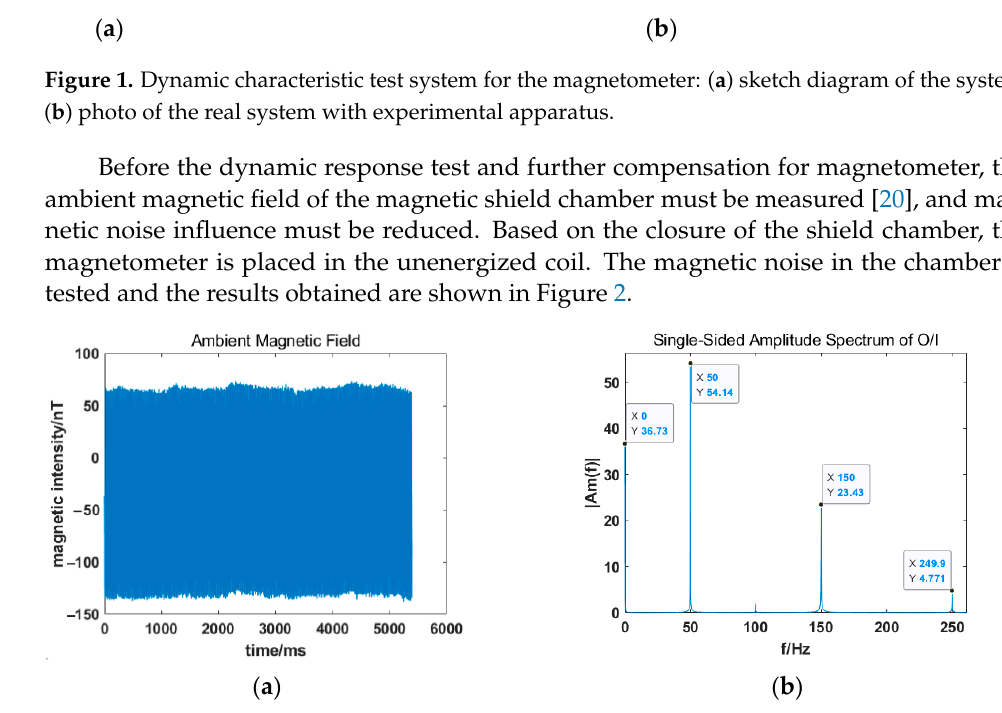
Figure 2. Ambient magnetic field of the magnetic shield chamber: ( a ) time domain diagram; ( b ) single-sided amplitude spectrogram.